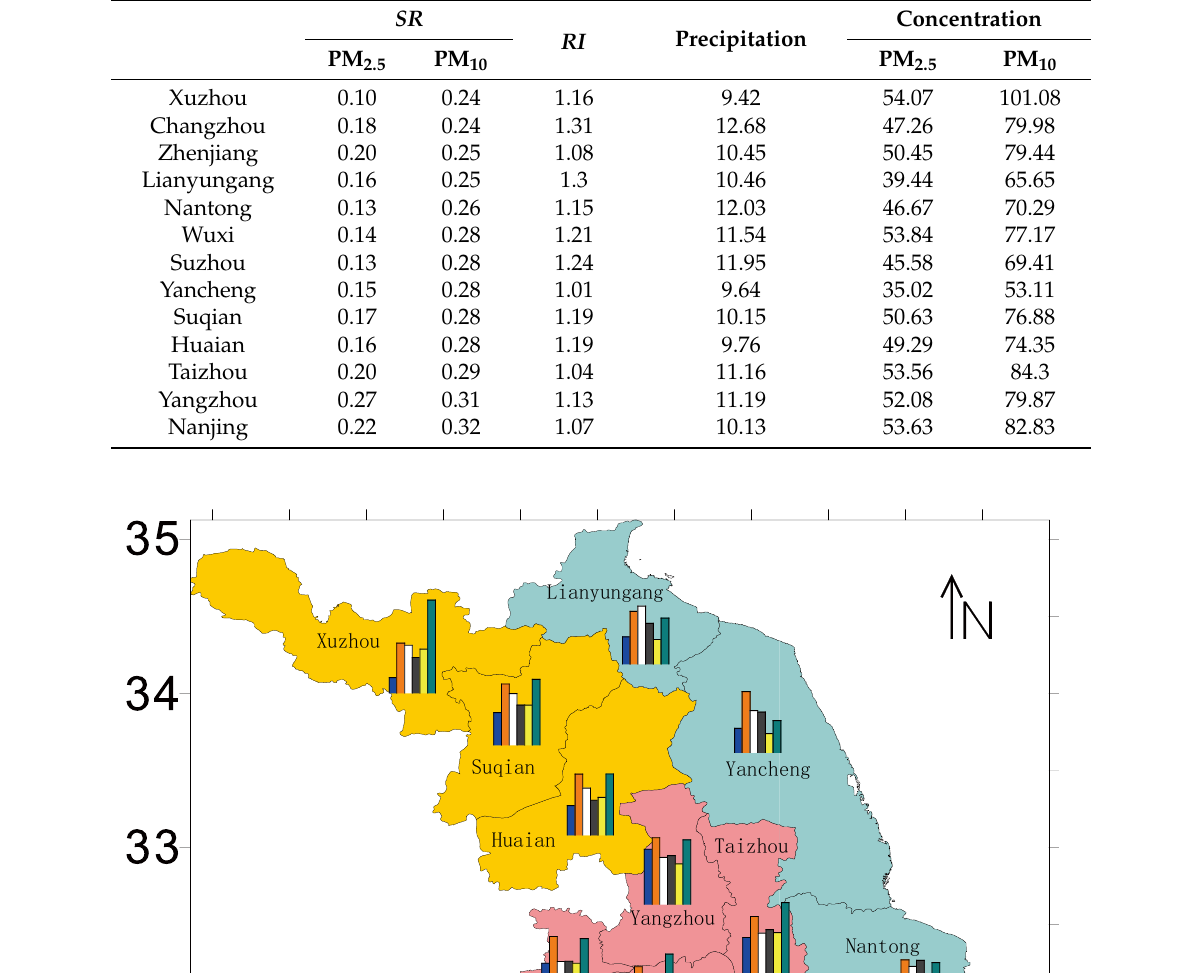
Table 1. Relationships between precipitation, RI , particle mass concentration, and SR in Jiangsu from 2013 to 2017 (data are consistent with Figure 6).